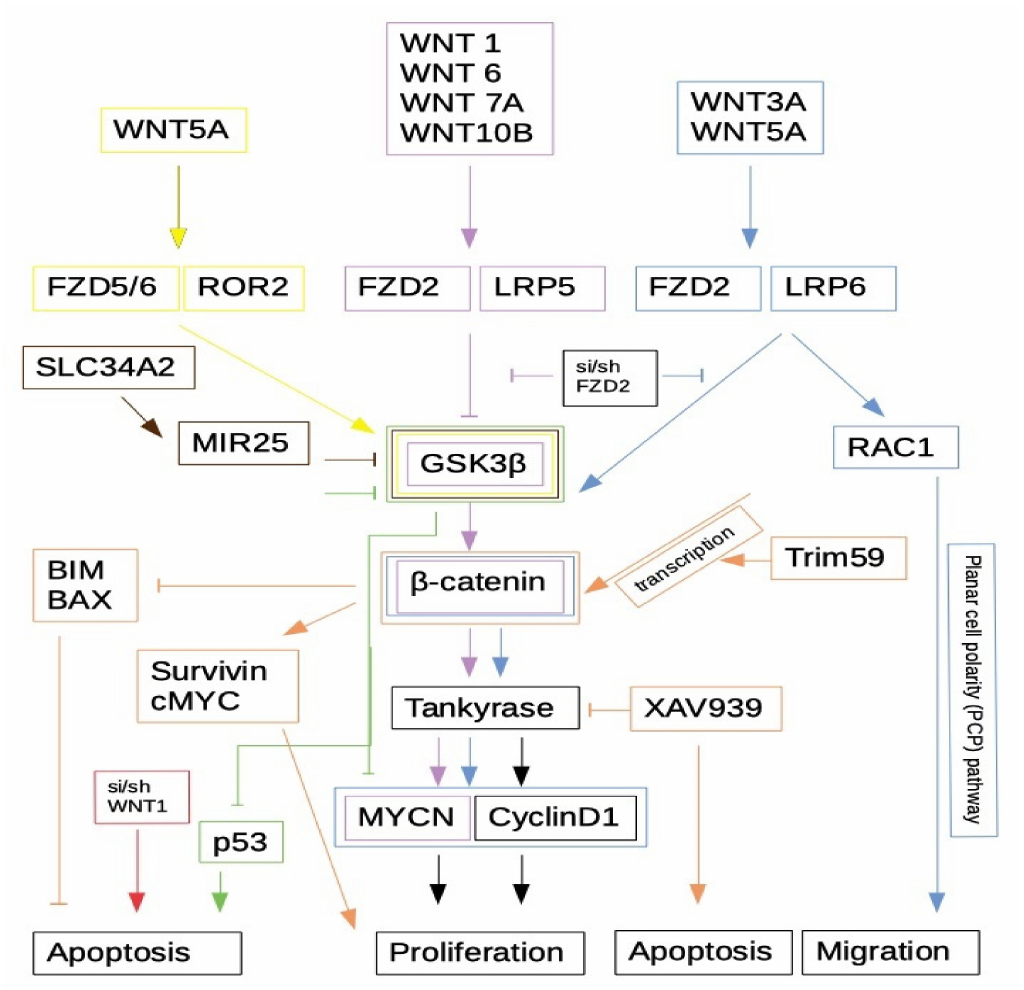
Figure 3. Synthesis of β -catenin involvement in NB as provided by several authors. Blue: [68]; purple: [66]; yellow: [17,18,91,92]; brown: [93]; green: [88]; orange: [70]; red: [67]. For detailed information please see